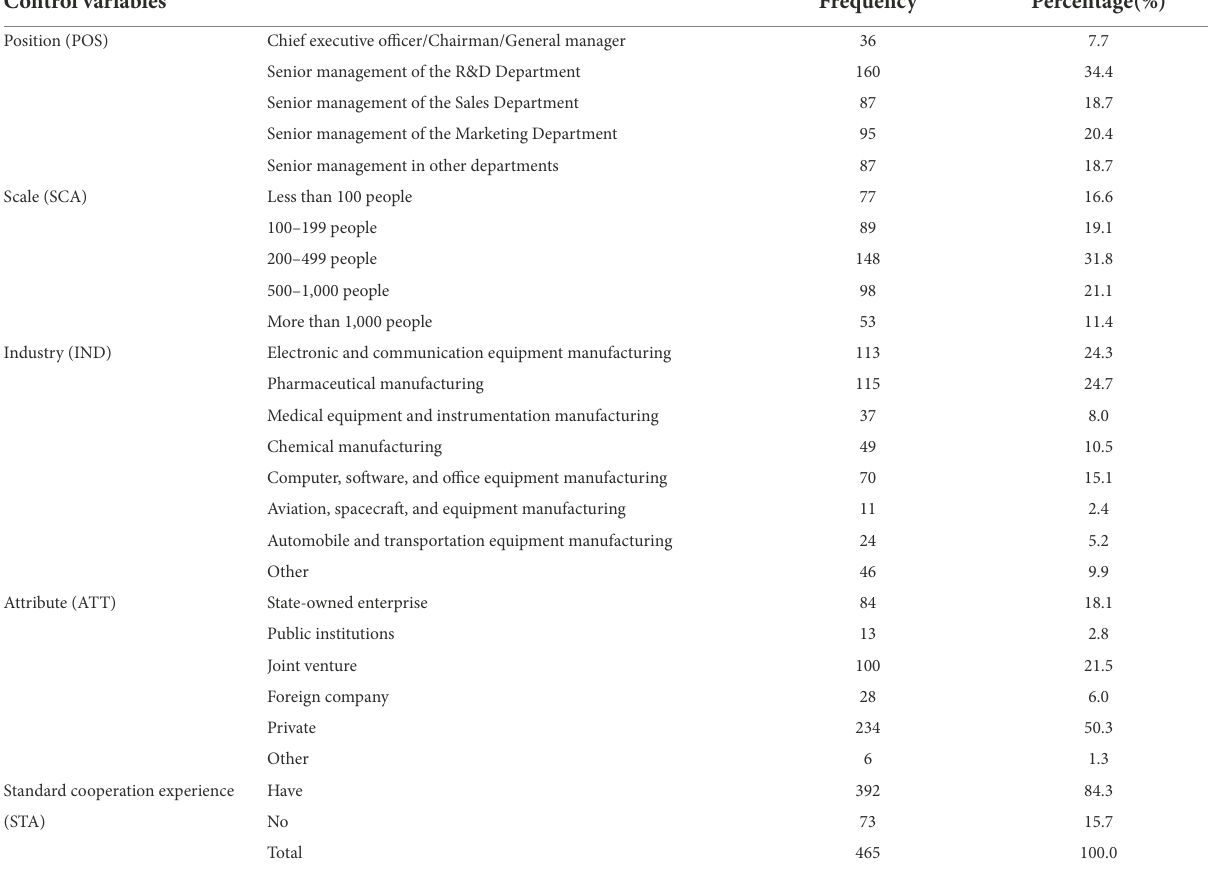
TABLE 1 Distribution table of sample characteristic information. Control